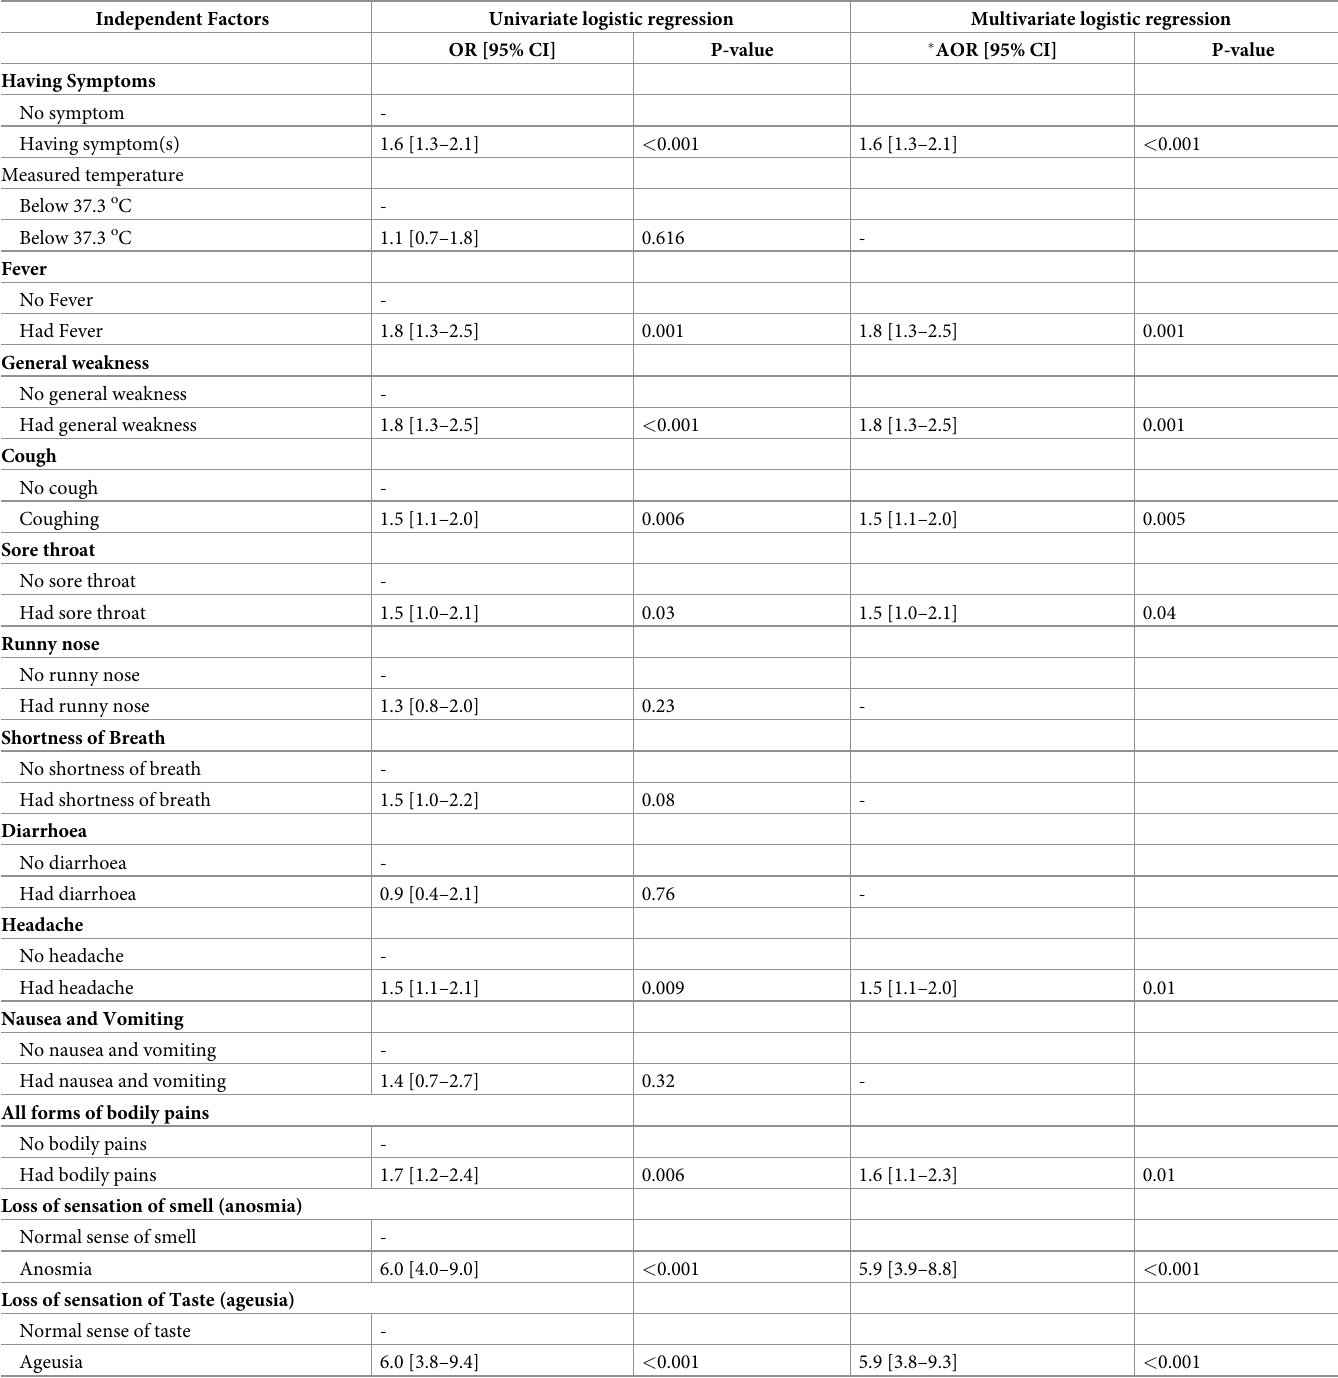
Table 2. Logistic regression of factors independently associate with positive SARS-CoV-2